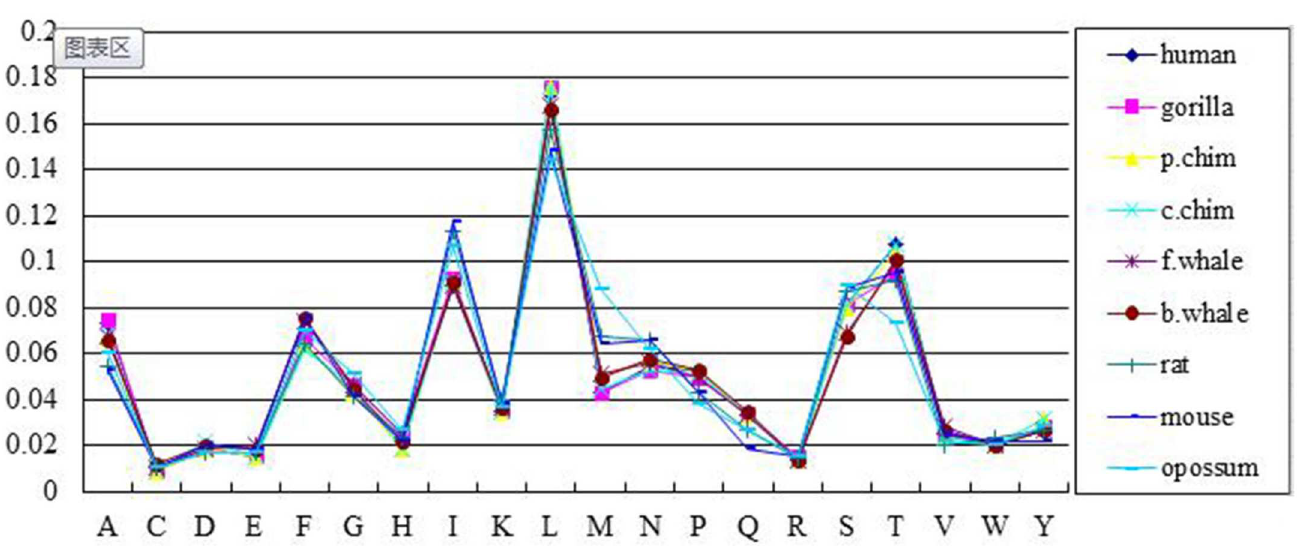
Fig 1. The content ratios of twenty amino acids in the ND5 dataset. The X axis denotesthe 20 amino acids and the Y axis denotesthe content ratios of each amino acid for the 9 sequences.